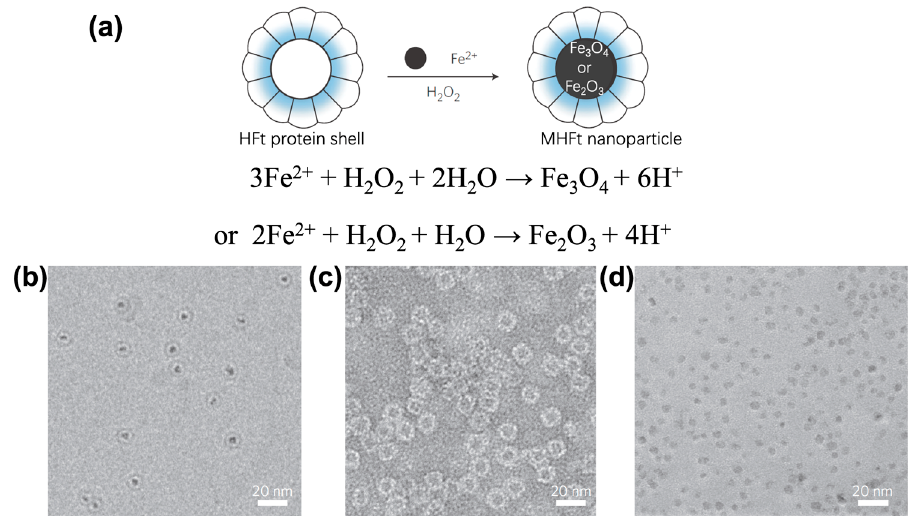
Figure 2. ( a ) The synthesis and structures of magnetoferritin comprised of only H chain subunits; ( b ) cryo-transmission electron microscopy (CryoTEM) image of MHFt nanoparticles; TEM image of ( c ) HFt shell and ( d ) iron core. Reprinted with permission from Ref 41 Copyright 2012 Nature publishing group.